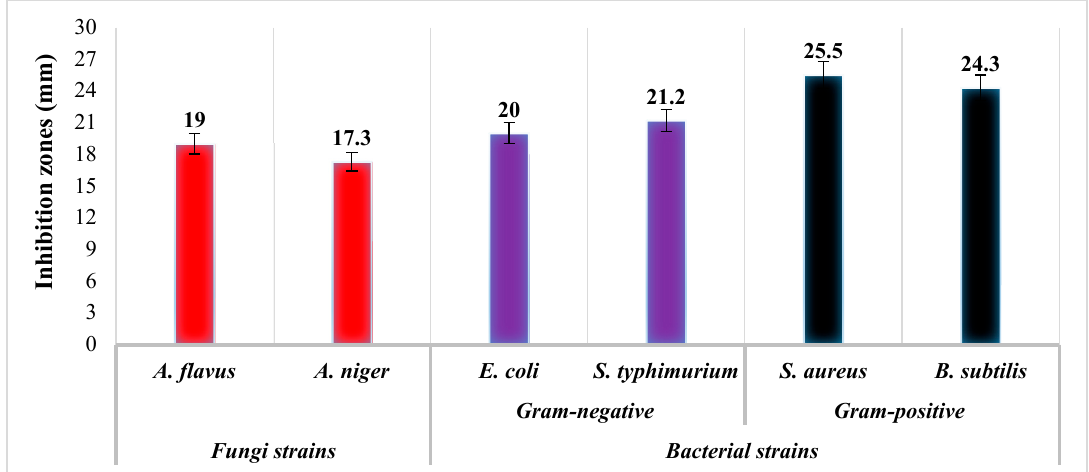
Figure 2. Effect of the chitosan nanoparticles on the inhibition of growth of the tested microorganisms.